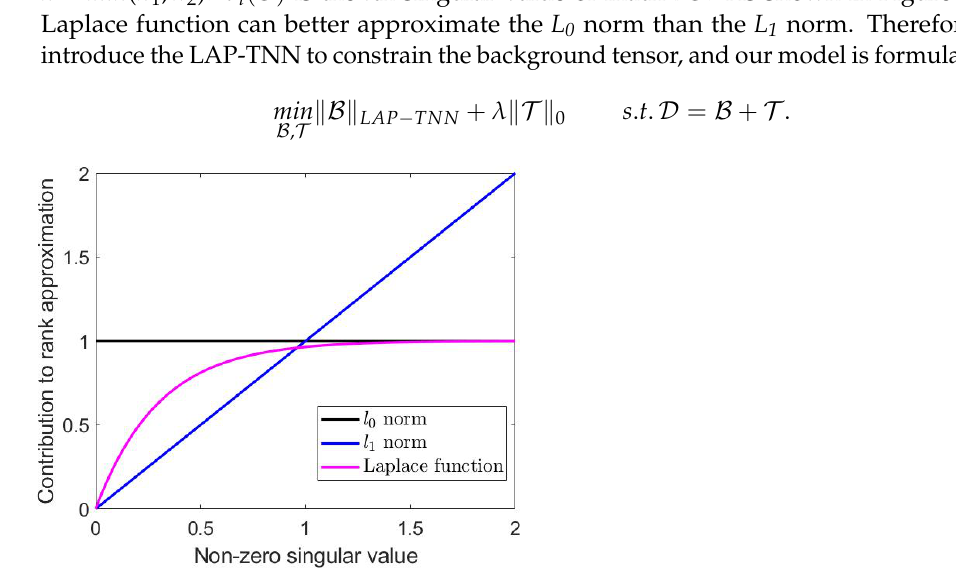
Figure 1. Comparison of l 0 norm, l 1 norm, and approximate rank of Laplace